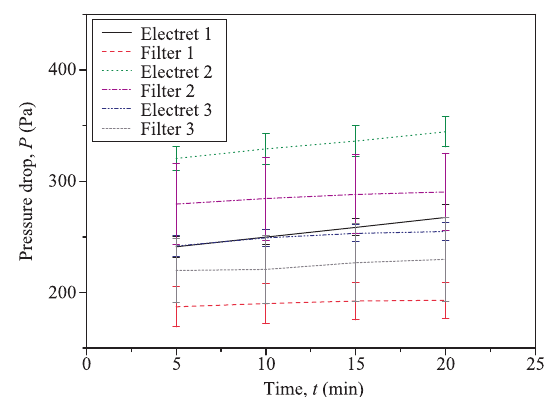
Fig. 9 Pressure drop across fibrous filters. Lines represent the mean values and error bars represent the standard